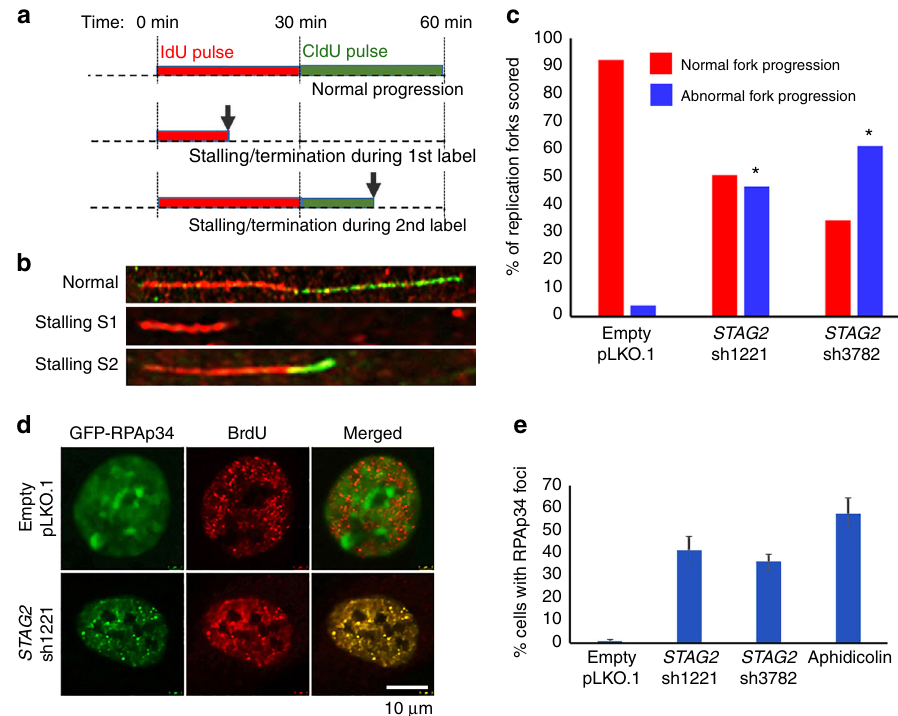
Fig. 2 The intra-S-phase cell cycle arrest caused by inactivation of STAG2 in primary human cells is due to replication fork stalling. a Schematic diagram of DNA combing assay to measure DNA replication progression in cultured human cells. Arrows indicate example of DNA fi bers with replication stalling or termination. b Microscopic images of representative single DNA fi bers showing normal replication fork progression (top) and replication fork stalling during IdU pulse (middle) and CldU pulse (bottom). c Quantitation of normal and abnormal replication forks scored from DNA combing assay of RPE cells following lentiviral transduction with empty pLKO.1 or two independent STAG2 shRNAs. More than 200 individual replication forks were evaluated from two independent experiments for each condition. * p < 0.0001, Mann – Whitney unpaired nonparametric t -test analysis. d Representative images of RPE cells showing accumulation of GFP-tagged RPAp34 at stalled replication forks following lentiviral transduction with STAG2 shRNA but not empty